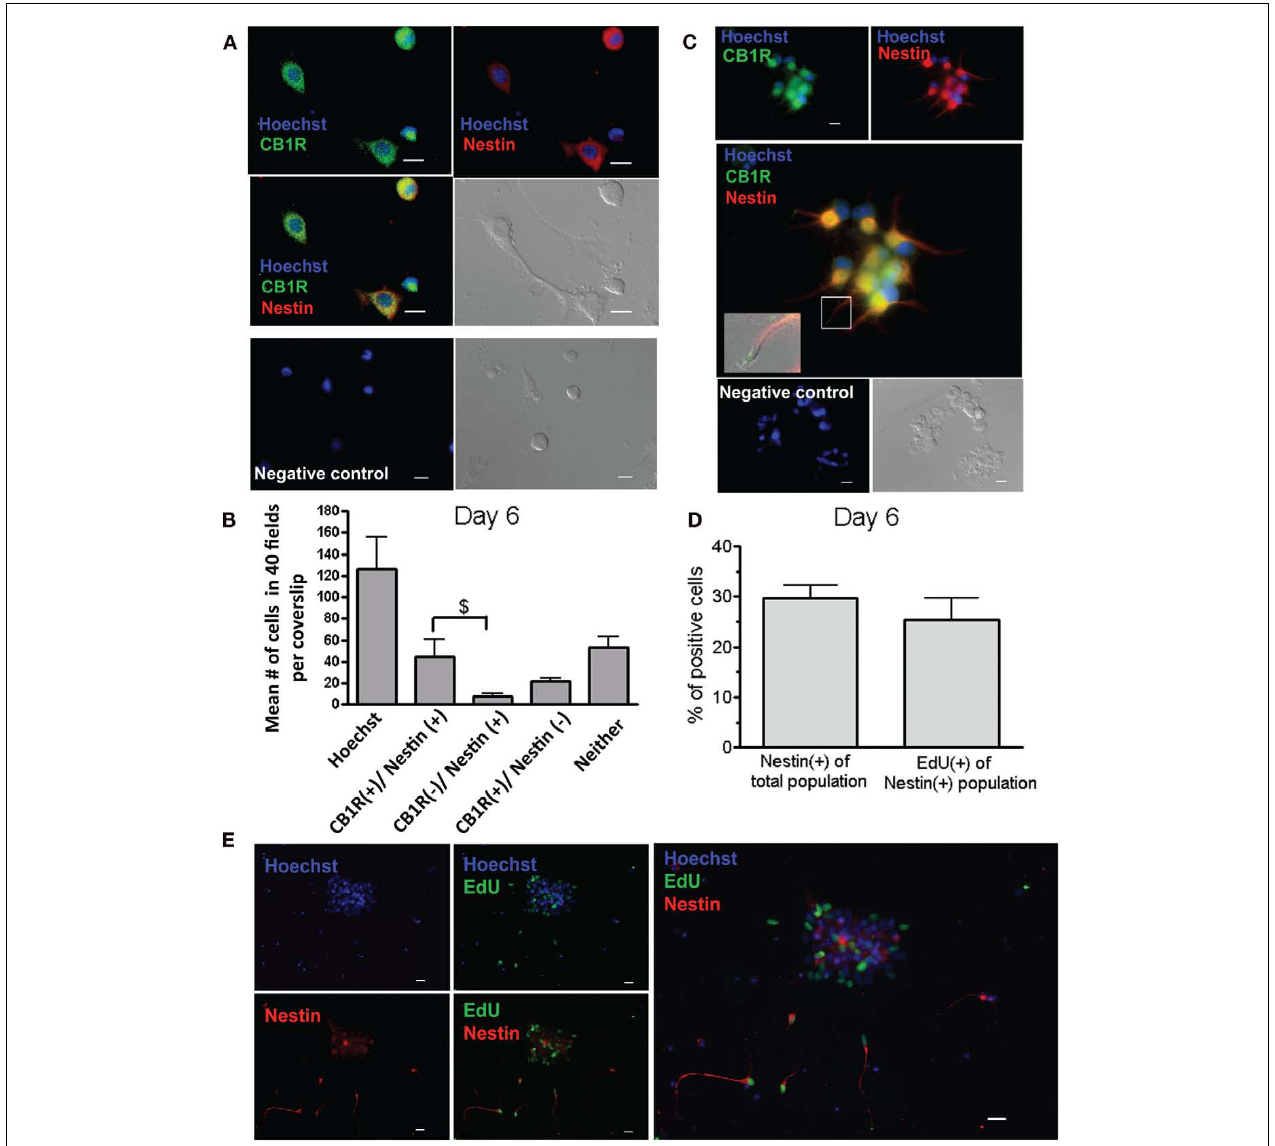
merged image (middle).The inset in the middle panel corresponds to the area outlined with the white box. For the inset the light picture is also overlapped to facilitate visualization of the cell extension.The inset shows CB1R labeling (green) at the end of an extension from a Nestin( + ) (red) cell.The negative control is shown in the bottom panel. (D) Percentage of Nestin( + ) cells in the entire population and of EdU( + ) cells within the Nestin( + ) population in mixed cultures on Day 6.Twenty fields were analyzed per coverslip ( n = 10 coverslips; mean + SEM). (E) Mixed cultures on Day 6 immunostained with anti-Nestin (red) and labeled with the mitogenic marker EdU (green). (A,C,E) The background fluorescence was subtracted from the image relative to the negative control. Nuclei were labeled with Hoechst 3392 (blue). Images were acquired with a 20 × objective; scale bars = 10 μ m.The image was selected to show a large number of Nestin( + ) cells.